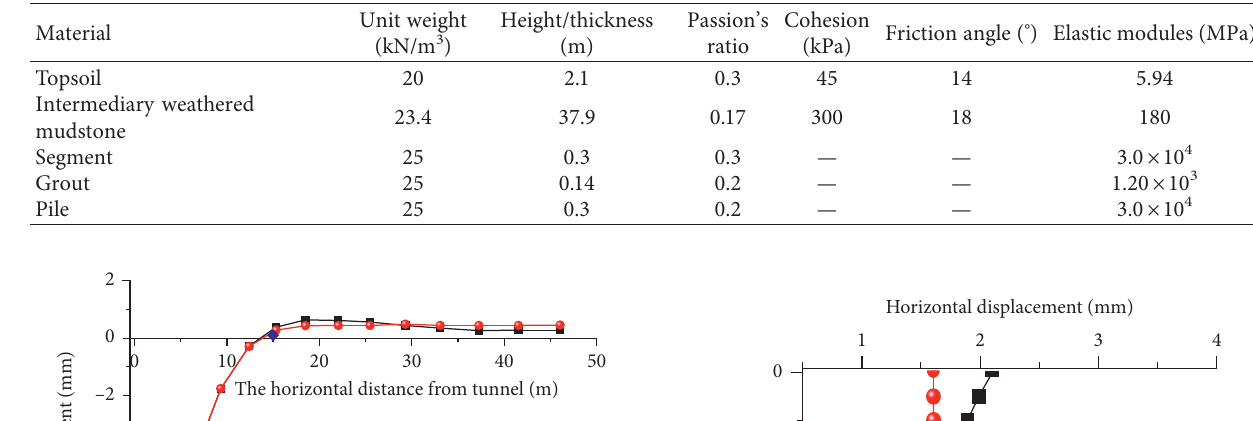
Table 1: Mechanical parameters of various materials.